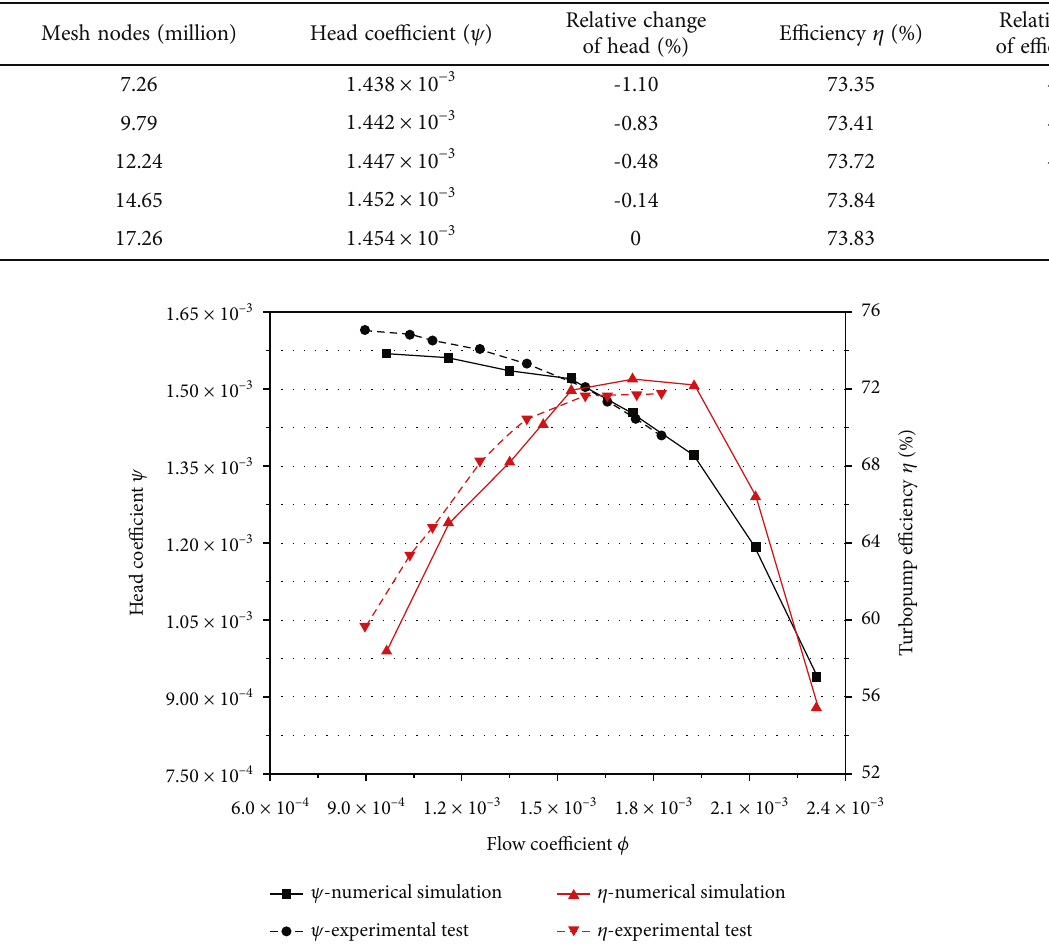
Table 2: Grid independence study results.